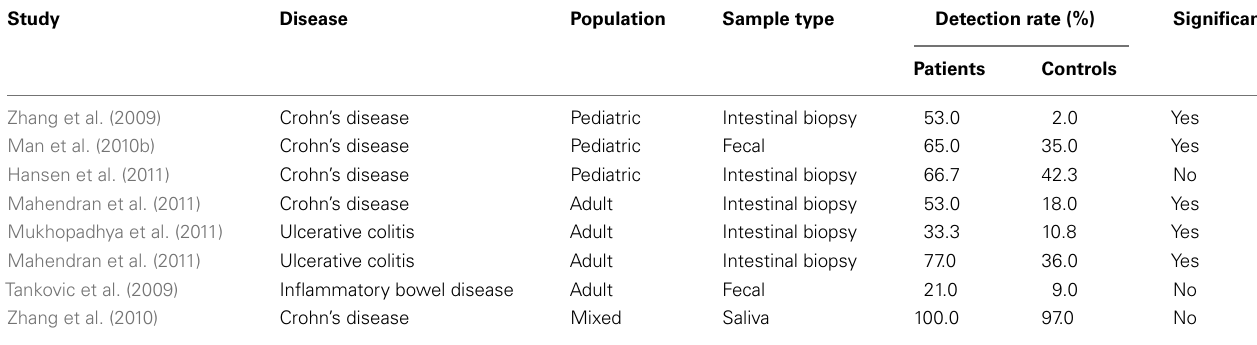
Table 2 | Detection rates of Campylobacter concisus in inflammatory bowel disease patients and